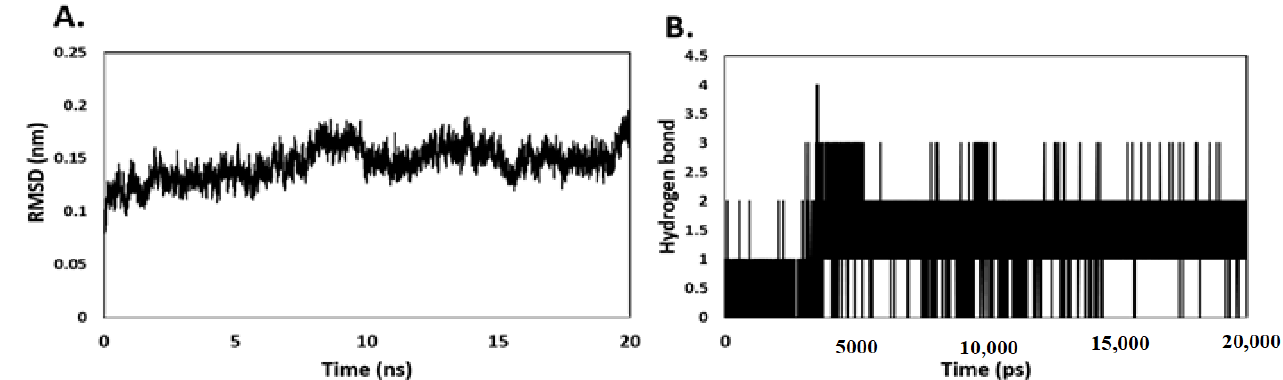
Figure 7. ( A ) The backbone RMSD of M6-VEGFR2 complex for 20 ns MD simulation. ( B ) Total number of molecular hydrogen bonds for the M6-VEGFR2 complex over the simulation time.